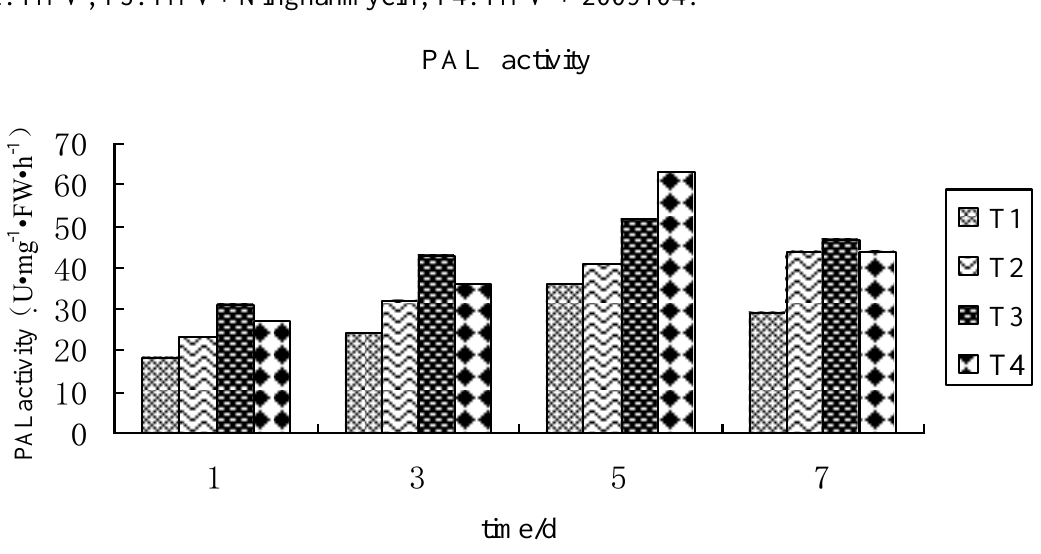
Figure 3. PAL activity in tobacco leaves in differential treatment groups T1: CK; T2: TMV; T3: TMV+ Ningnanmycin; T4: TMV + 2009104. PAL activity